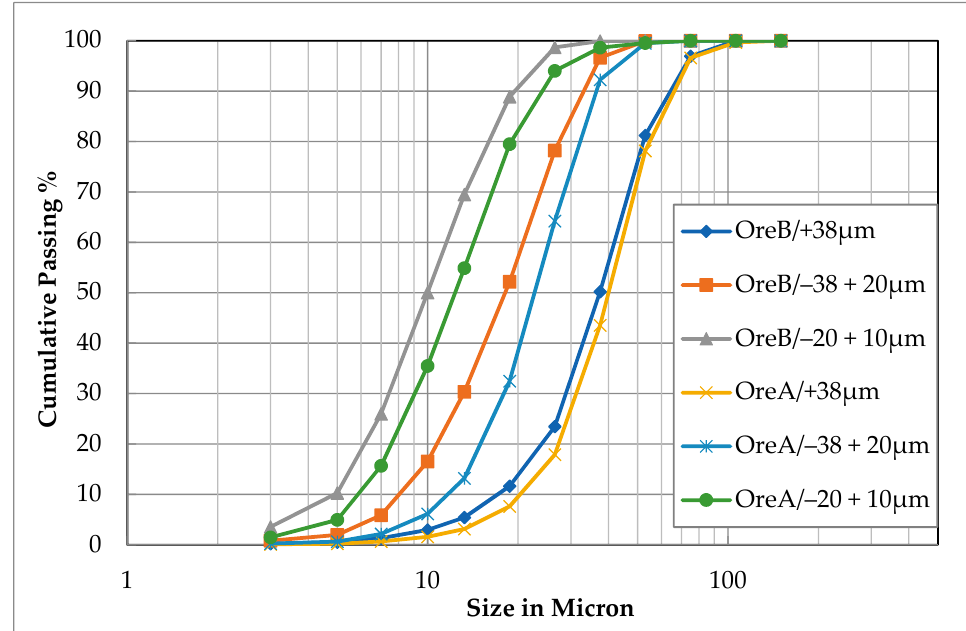
Figure 1. Grain size distributions of pyrite in size fractions of Ore A and B .